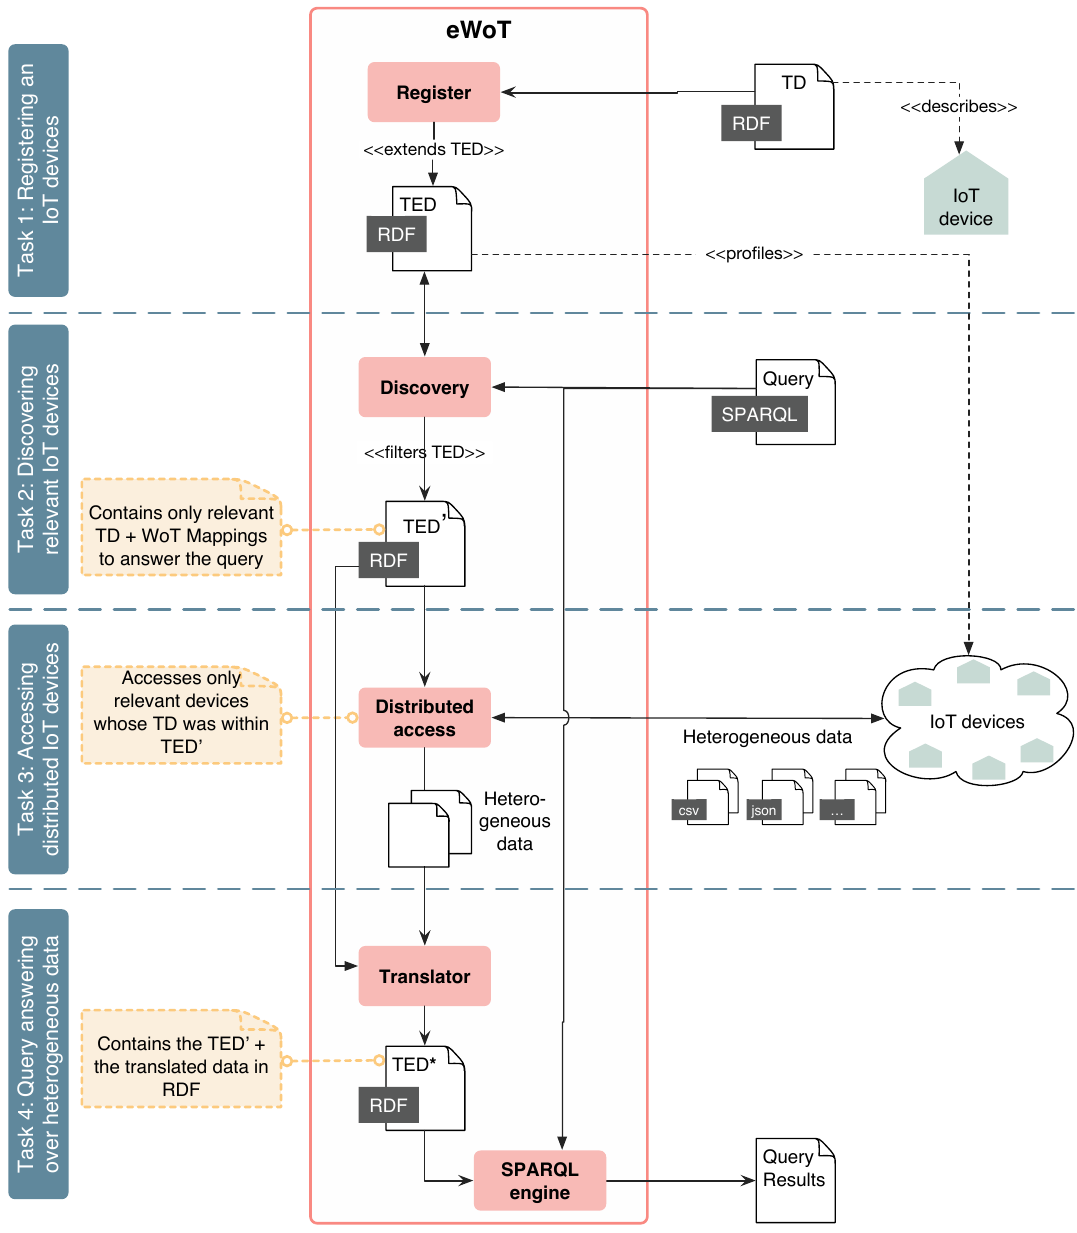
Figure 3. eWoT architecture overview. RDF: Resource Description Framework; TD: Thing Description; TED: Thing Ecosystem